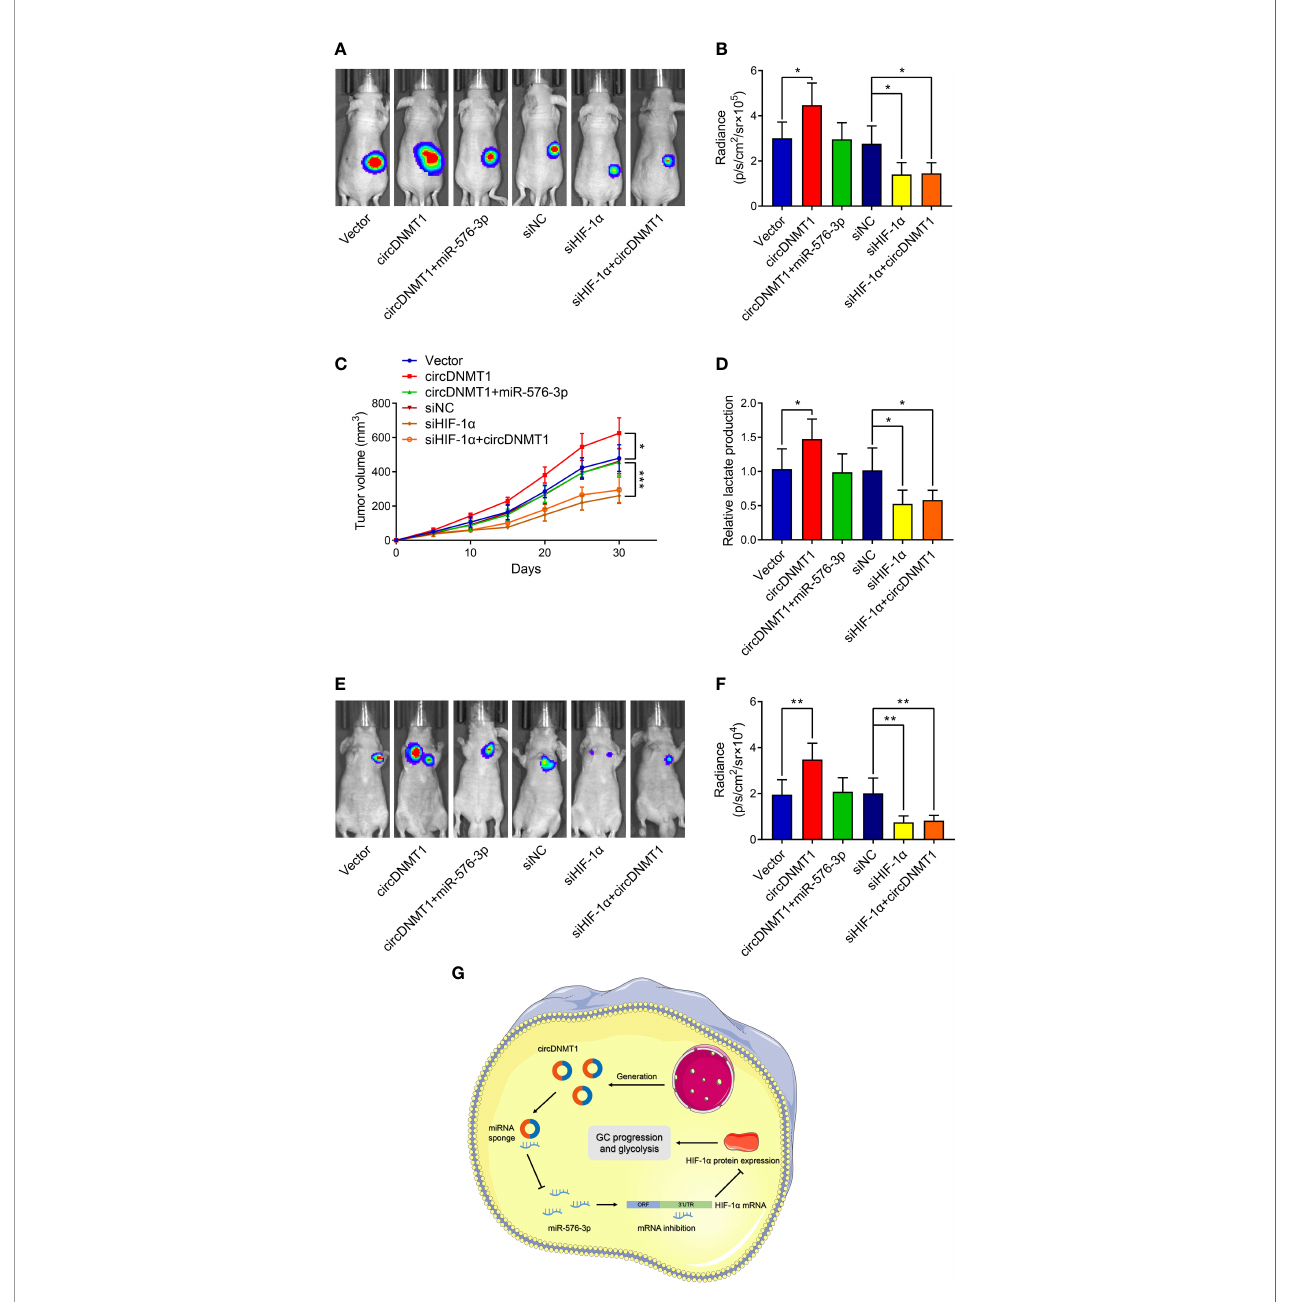
FIGURE 7 | circDNMT1/miR-576-3p/HIF-1 a axis regulated GC growth and metastasis in vivo . (A) Representative bioluminescence images at 30 days after subcutaneous injection of luc-HGC-27 cells. They could be divided into two groups: i) The cells stably carrying lentivirus with vector or HIF-1 a overexpression plasmids and transfected with NC or miR-576-3p mimics; ii) The cells transfected with NC shRNA or HIF-1 a siRNA and carrying lentivirus with vector or circDNMT1 overexpression plasmids. (B) Luminescence signals in (A) represented by overlaid false-color images with the signal intensity. (C) Curves of tumor volumes as in (A) at the indicated time. (D) Lactate acid production was determined in the tumor tissues from (A) . (E) Representative bioluminescence images at 30 days after tail vein injection of luc-HGC-27 cells as in (A) . (F) Luminescence signals in (E) represented by overlaid false-color images with the signal intensity. (G) Schematic illustration of the role and mechanisms of circDNMT1 in regulating GC progression. Data were presented as means ± SD. *P < 0.05, **P < 0.01, ***P <